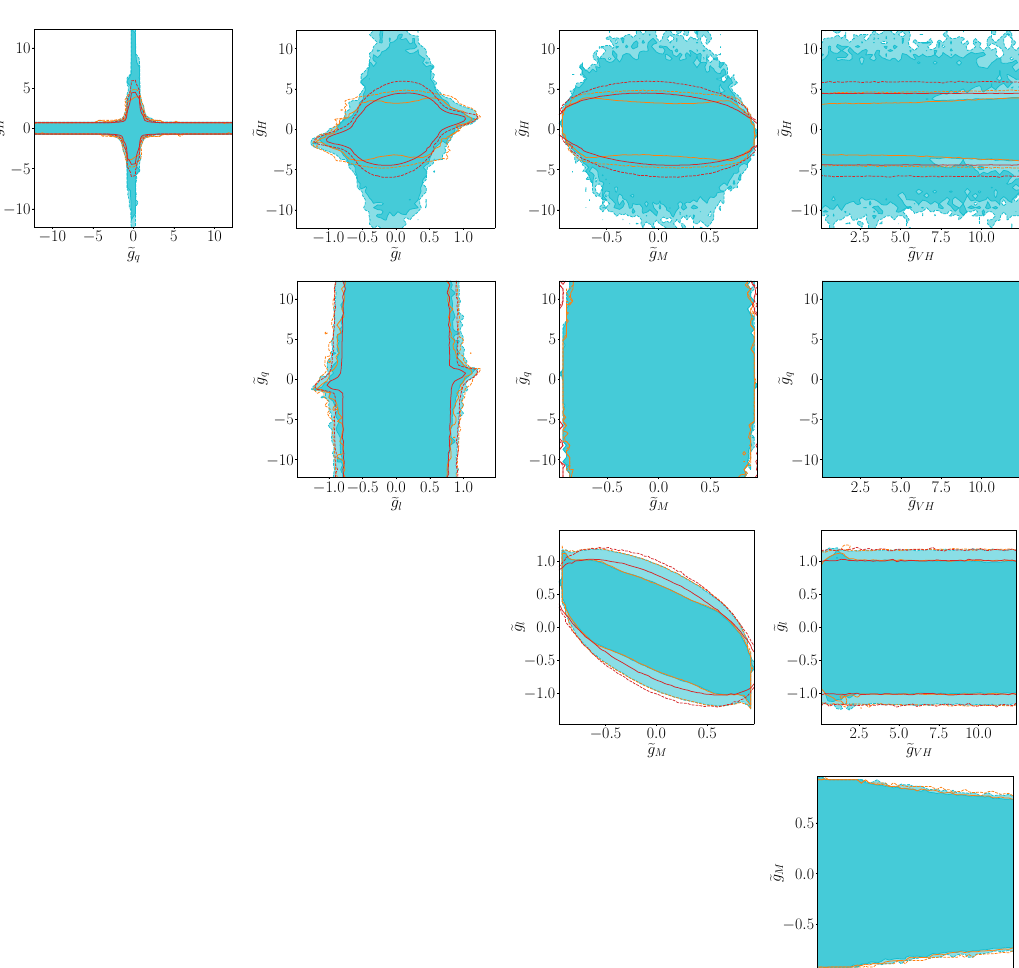
Figure 9: 5-parameter global fit of the full data set to the model parameters from = 4TeV. Profiled ∆ χ 2 = 2.3 ( ∆ χ 2 = 5.991 ) contours are shown Eq.(10) for fixed m V as solid (dashed) lines. Red (orange) curves indicate the results obtained with tree (1-loop) matching onto the SMEFT and a fixed matching scale Q = m region shows the results from 1-loop matching, profiled over Q = 500GeV ... m = 4TeV. The analysis is performed varying ˜ g triplet mass m V = − 1 ... 1, ˜ g > 0 and all other coupling parameters in the perturbative range region ˜ g M VH ˜ g = − 4 π ... 4 π